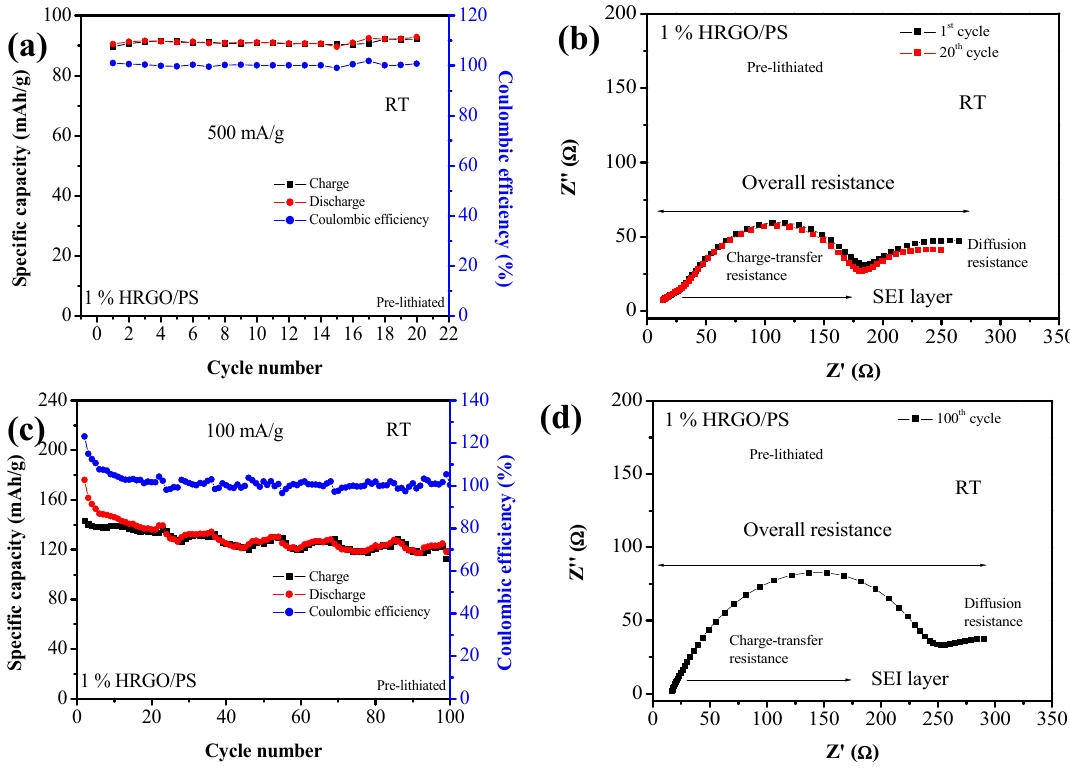
Figure 9. ( a ) Cycling performance of pre-lithiated 1% HRGO / PS at a current density of 500 mA / g. ( b ) Nyquist plot of pre-lithiated 1% HRGO / PS electrodes after the 1st and 20th cycle. ( c ) Cycling performance of pre-lithiated 1% HRGO / PS at a current density of 100 mA / g for 100 cycles. ( d ) Nyquist plot of pre-lithiated 1% HRGO / PS electrodes after the 100th cycle.